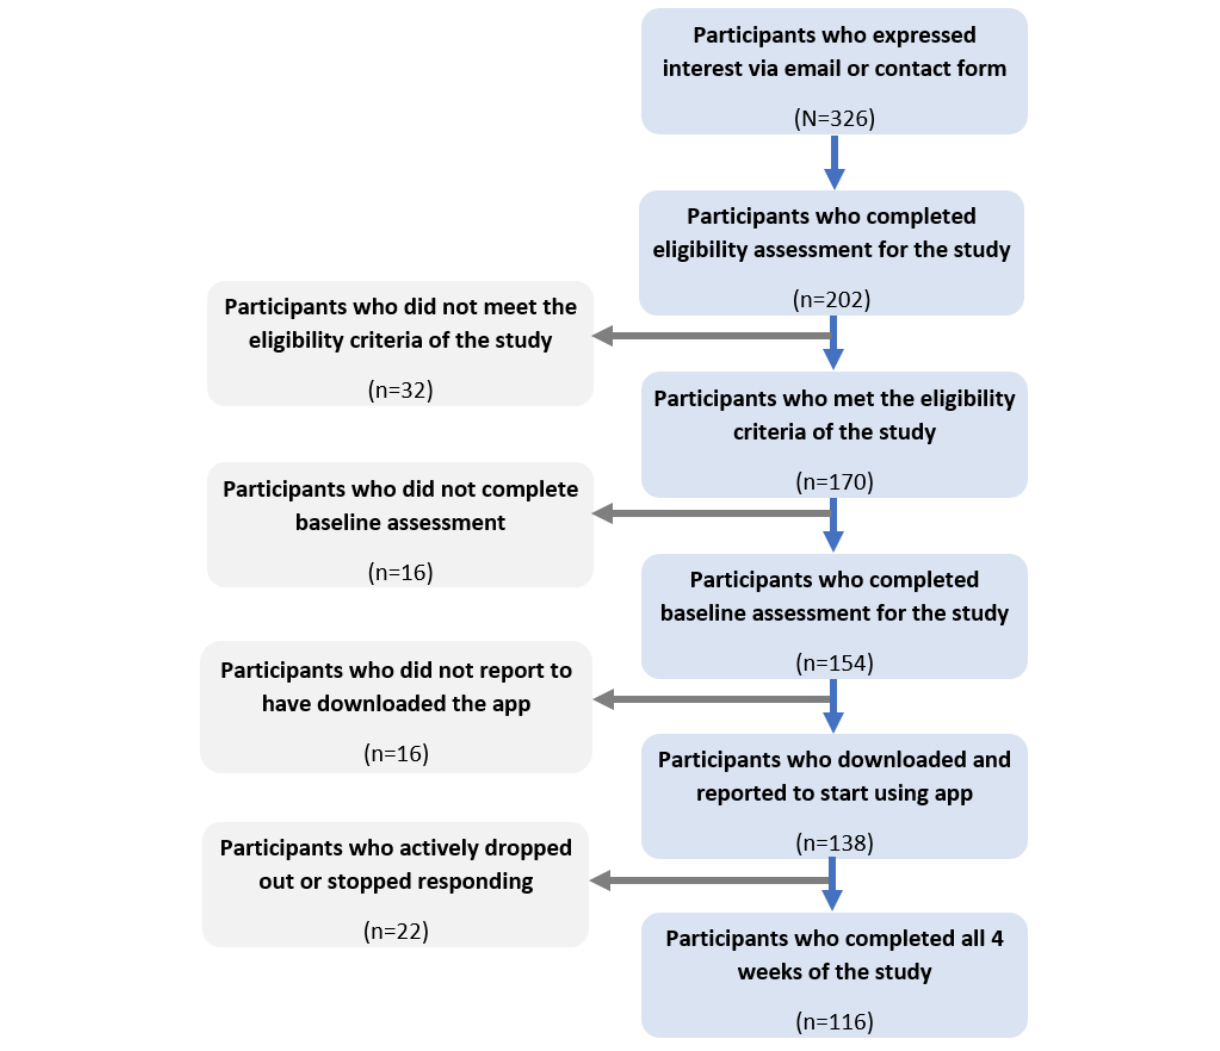
Figure 3. Overview of participant numbers from expression of interest to study